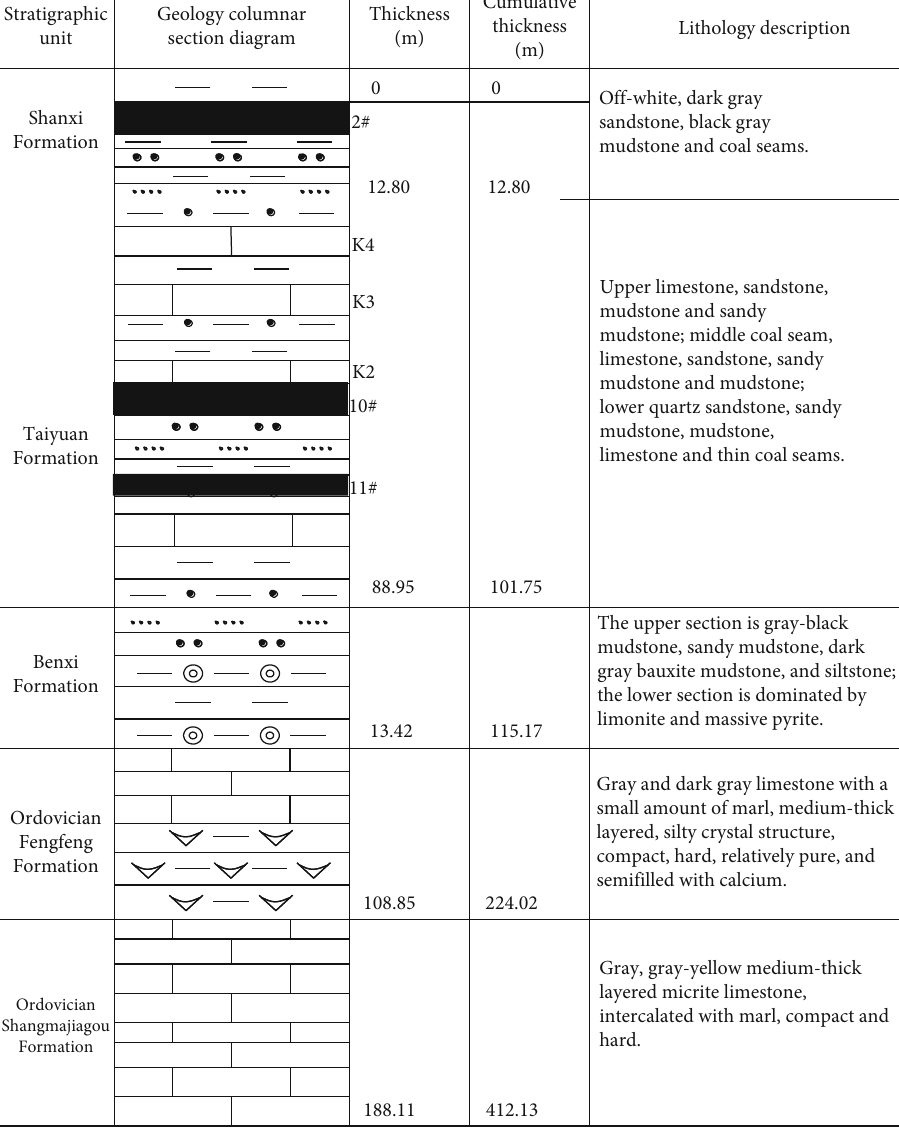
Figure 2: Geological columnar section diagram of the Liyazhuang coal